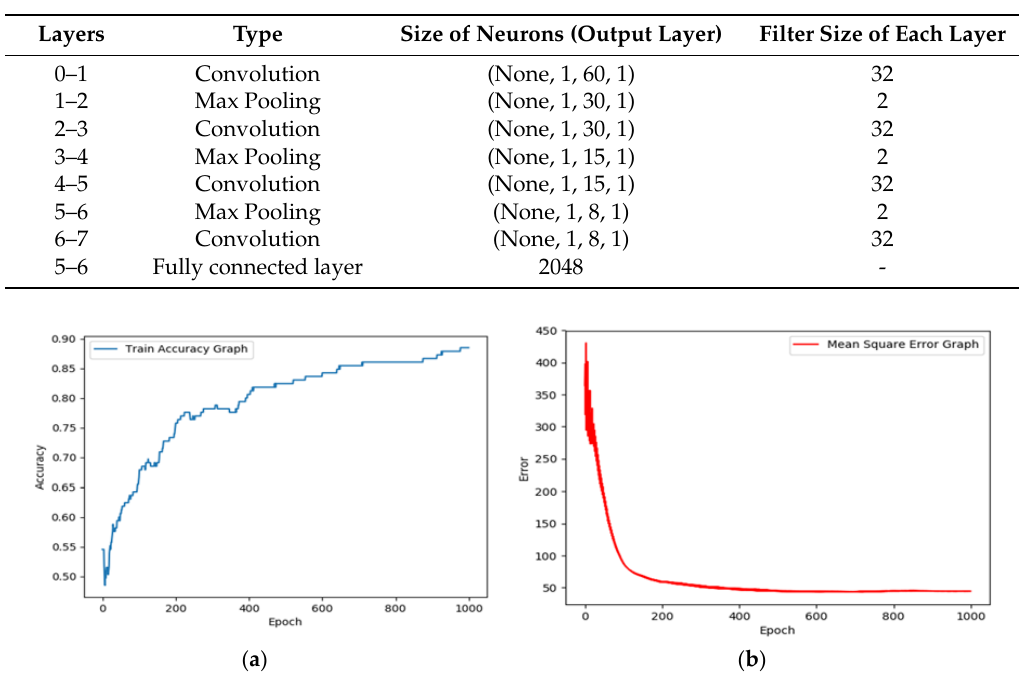
Table 1. Details of the proposed CNN algorithm with description of filter size and number of neurons used for each convolution and max pooling layer.